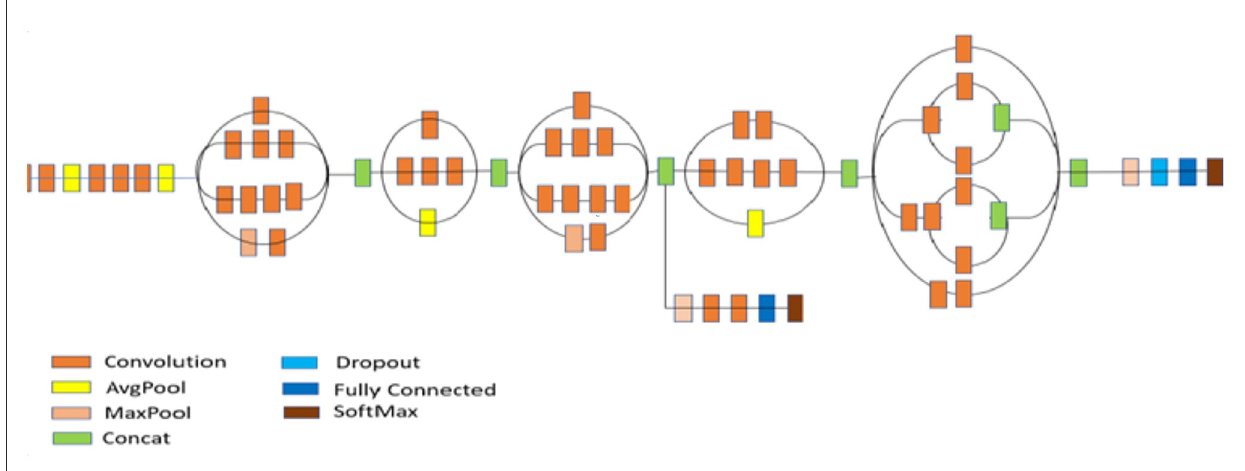
FIGURE9 Architecture of inception V3 model (Szegedy et al., 2016).